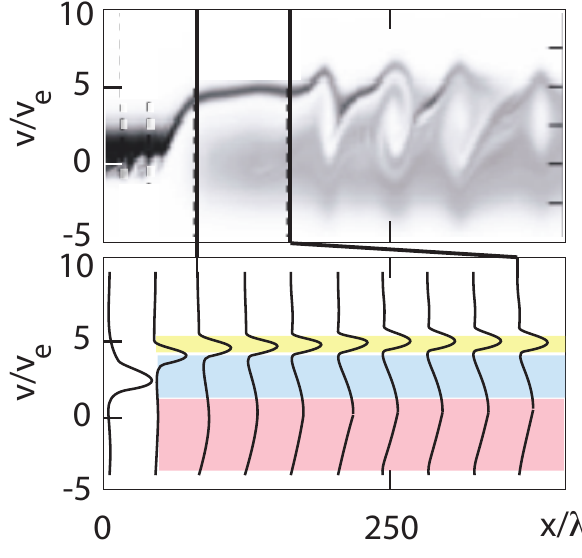
Fig. 1. An example of electron hole formation in a one-dimensional simulations (data from Newman et al., 2002). The upper panel shows the phase-space, (x,v) , of electrons, which are injected as a warm (thermal speed v e ) current carrying electron beam on the left, satisfying the Buneman condition. Velocity is scaled in terms of the thermal speed, v e , space in terms of the Debye length, λ D = v e /ω e . Evolution into a cold electron beam at velocity v ≈ 5 v e is readily seen in relation to the generation of phase-space holes from where electrons are emptied. Parallel to beam evolution, a hot electron component is generated by trapping and heating. Hole structure is not simply dipolar, as suggested by theory. Instead, negative veloc- ities indicate reflection of electrons and complicated holes, consist- ing of several highly dynamical electron layers of low phase-space density. The lower panel shows average distribution cuts at different locations in space. Indicated yellow is the cold accelerated beam, blue the hole region that is about void of electrons, red the warm hole-trapped electron population. Spatial hole extension is several ten Debye lengths. The phase-space extension of the hole is of the order of . 10 v e , substantially wider than the thermal width ( ∼ 2 v e ) of the initial